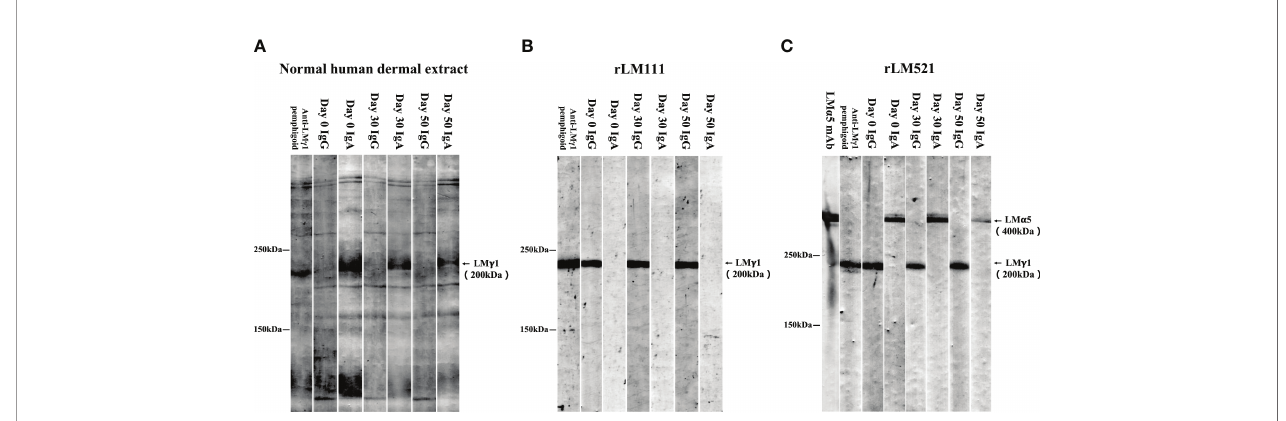
FIGURE 4 | Immunoblotting analyses. Immunoblotting analyses of normal human dermal extract (A) , rLM111 (B) and rLM521 (C) were performed for IgG and IgA autoantibodies against LM g 1 and LM a 5 in patient sera collected at Days 0, 30 and 50. The serum of an anti-LM g 1 pemphigoid patient and anti-LM a 5 monoclonal antibody (LM a 5 mAb) were used as